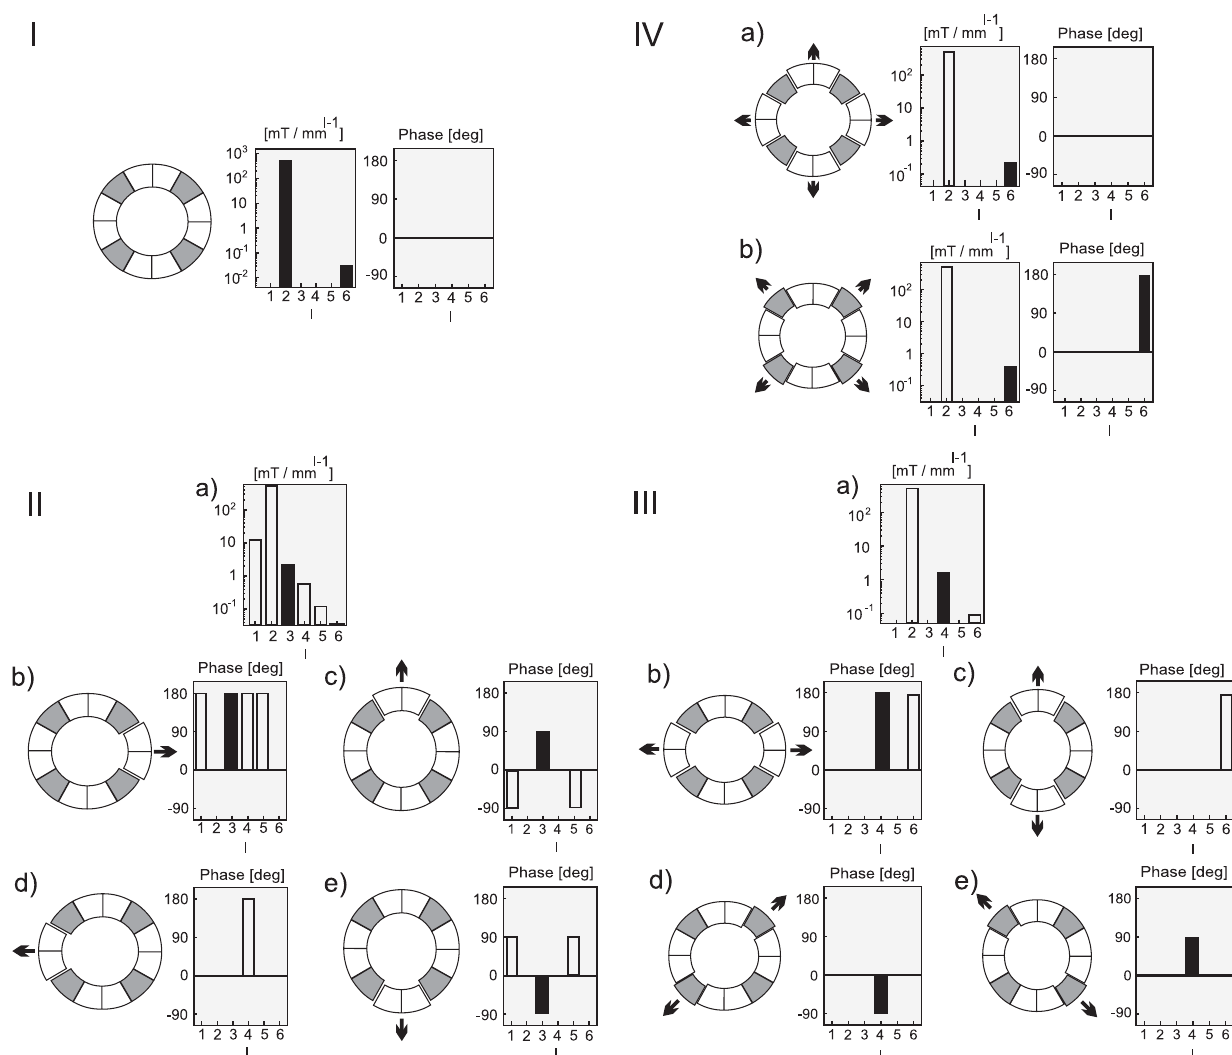
FIG. 6. The introduction of HOMFC with the PMQ having the same orientation as in Fig. 1. Panel I: Magnitude and phases of the calculated magnetic field using the ideal arrangement of permanent magnet wedges. Panel II: Displacing a single pair of tuning wedges by 150 (cid:3) m introduces a dominant sextupole (IIa). Independent from the specific pairs of tuning wedges displaced, panels IIb–IIe show the effect on the phases of the introduced field components by moving tuning wedges at (cid:4) ¼ 0 (cid:2) , 90 (cid:2) , 180 (cid:2) , 270 (cid:2) . Panel III: Two opposite pairs of tuning wedges are displaced by 150 (cid:3) m , this introduces a dominant octupole. Panel IIIa shows the effect on the magnitude of the field components. Panel IIIb–IIIc show the effect on the phases of the introduced field components moving tuning wedges at (cid:4) ¼ 0 (cid:2) and 90 (cid:2) affecting a 4 . Moving the positioning wedges as shown in panels IIId–IIIe affect b 4 . Panel IV: All pairs of tuning wedges are displaced by 150 (cid:3) m ; this introduces a dominant dodecapole. The effect on the magnitudes are shown in panel IVa. Panels IVb and IVc show distinct pairs of tuning wedges which are moved and the effect on magnitudes and phases of the field components. The application of distance holders might be required as in Fig.